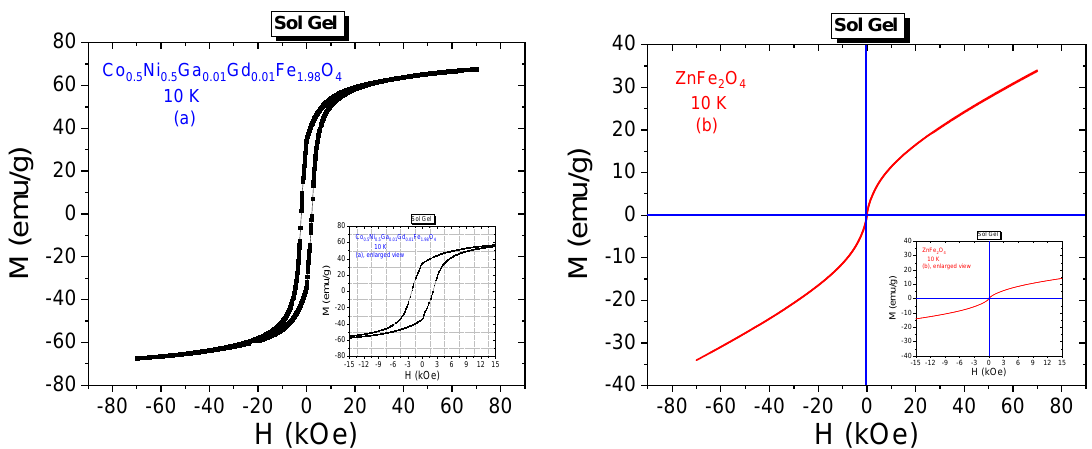
Figure 8. M-H curves recorded at 10 K from ( a ) Co 0.5 Ni 0.5 Ga 0.01 Gd 0.01 Fe 1.98 O 4 and ( b ) ZnFe 2 O 4 NPs synthesized by sol-gel method. Enlarged views were embedded.